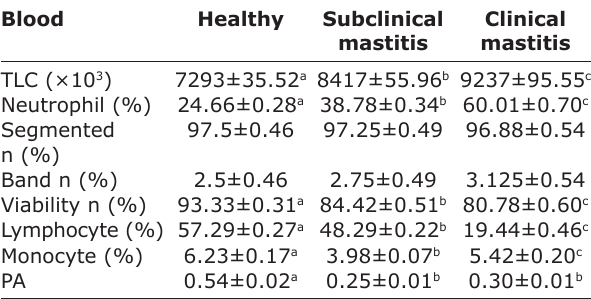
Table-2: Milk SCC, differential leukocyte counts, phagocytic activity of milk neutrophils, healthy, subclinical, and clinically infected KF